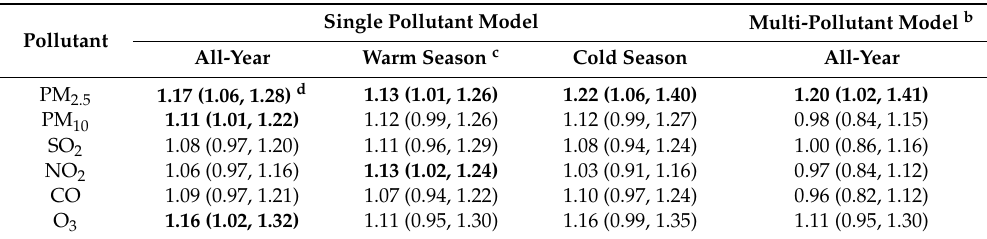
Table 2. Increased risk of TB and corresponding 95% CIs associated with 10 µ g / m 3 increase in air pollutants a on the 7th lag day for single- and multi-pollutant models. Pollutant Single Pollutant Model Multi-Pollutant Model b All-Year Warm Season c Cold Season All-Year PM 2.5